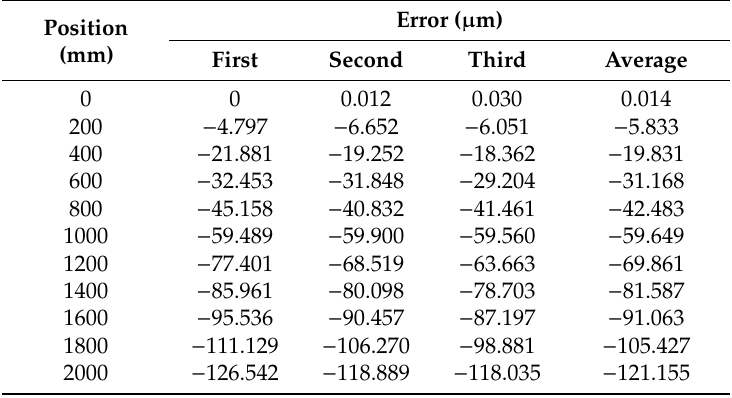
Table 7. Position error in the X direction.